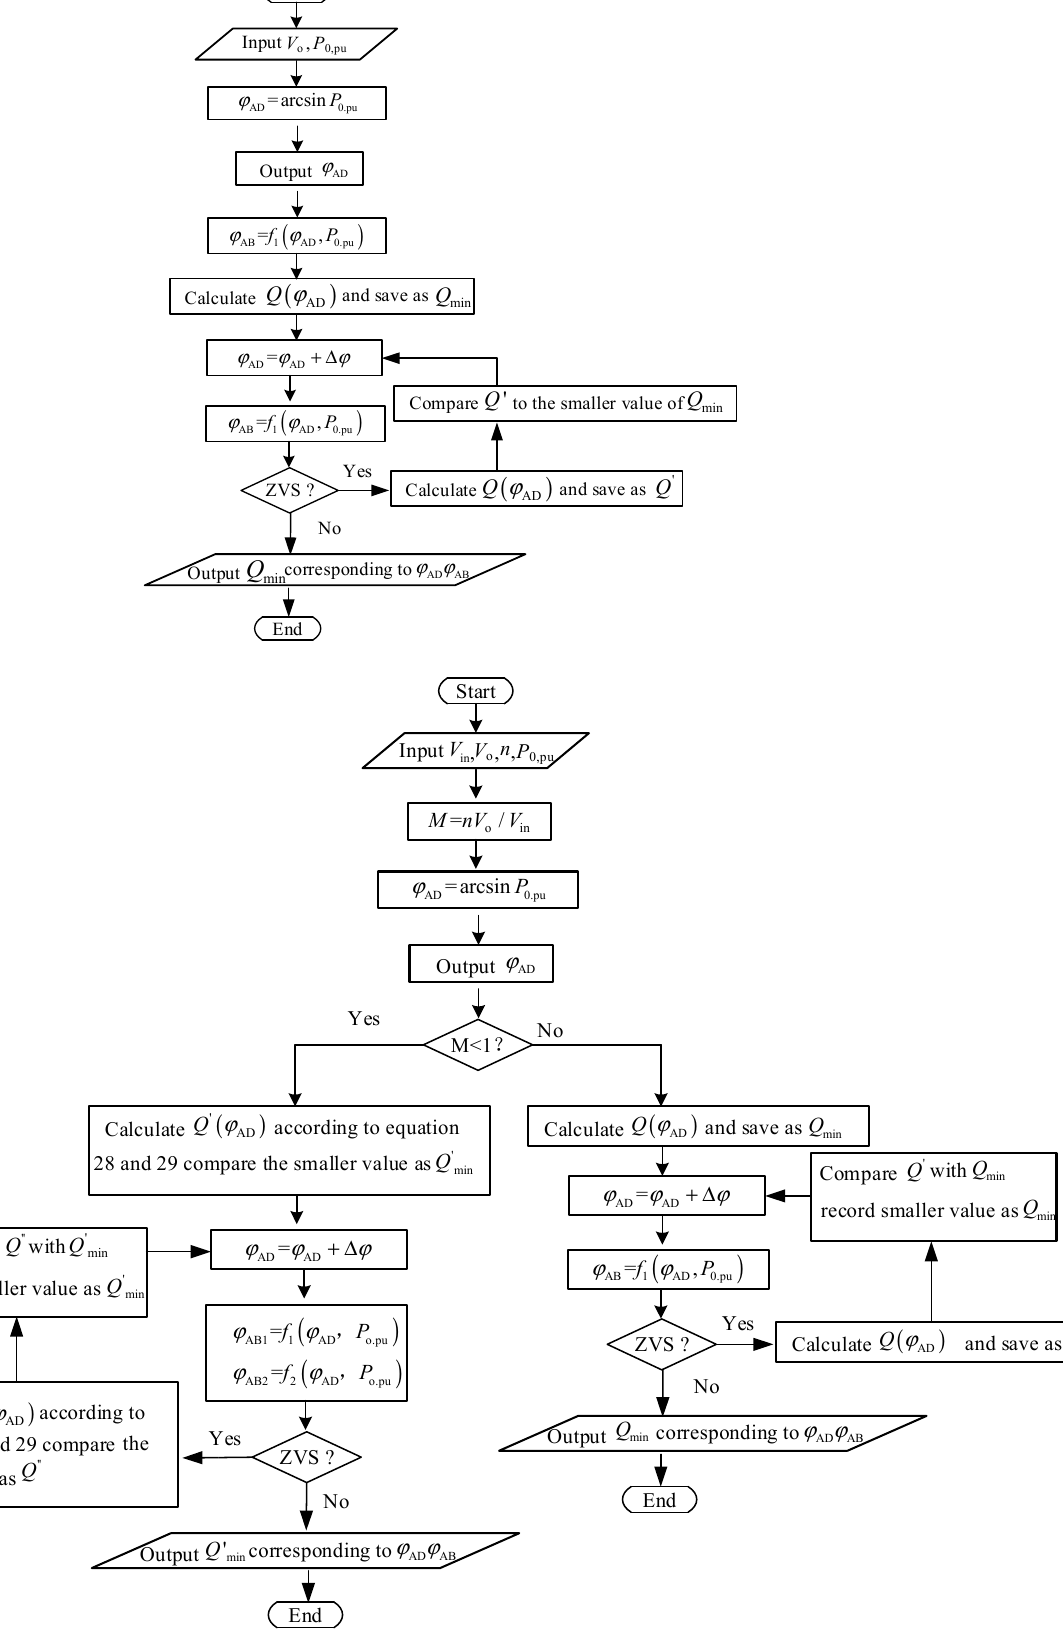
Figure 19. Reactive power minimization optimization seeking control flow.